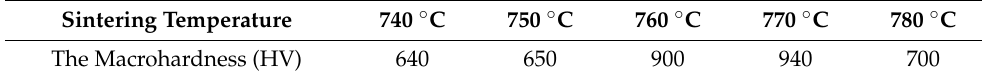
Table 1. Macroscopic hardness of SD/Cu-Fe sandwich